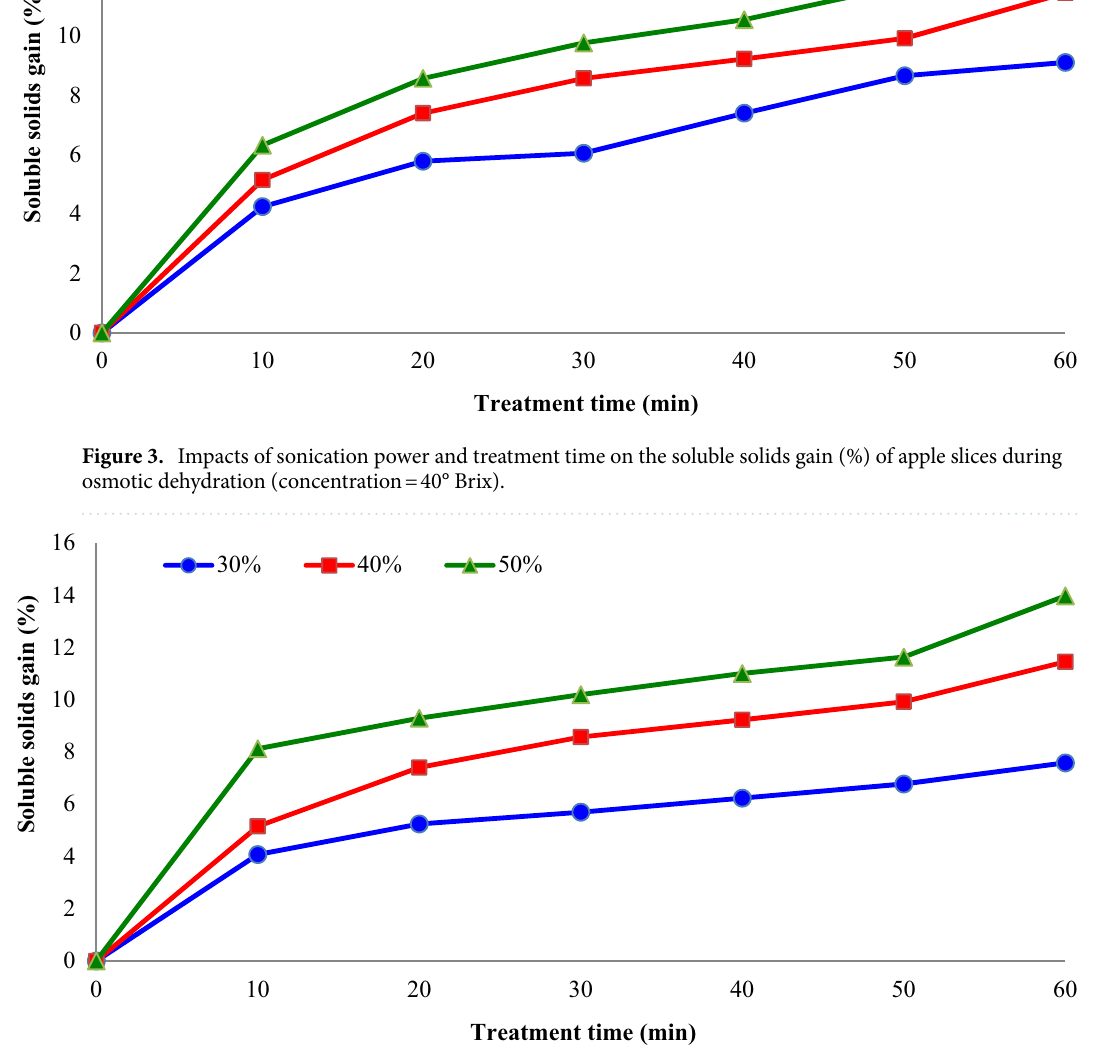
Figure 4. Impacts of sucrose solution concentration (°Brix) and treatment time on the soluble solids gain (%) of apple slices during osmotic dehydration (sonication power = 75